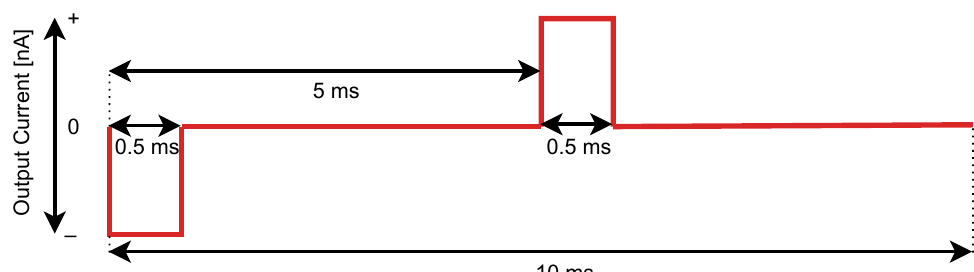
Figure 14. Single 10ms period of the current pattern used to determine Neurostim-3 ASIC analogue signal response. Both pulses are of the same amplitude resulting from Digital-Analogue Converters (DACs) configuration but of different